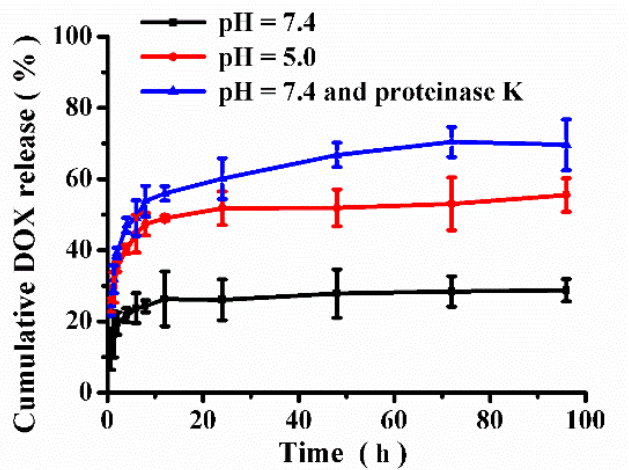
Figure 7. In vitro release of DOX in the presence or absence of proteinase K (6 U/mL) in DOX@P 2 -1 micelles (0.5 mg/mL) at different pH values of 7.4 and 5.0 at 37 °C.